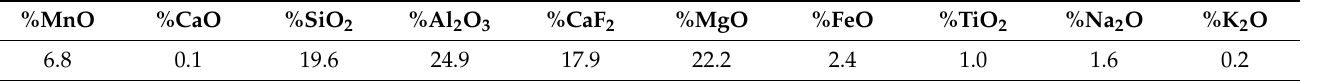
Table 2. Bulk chemistry of flux used in welding tests